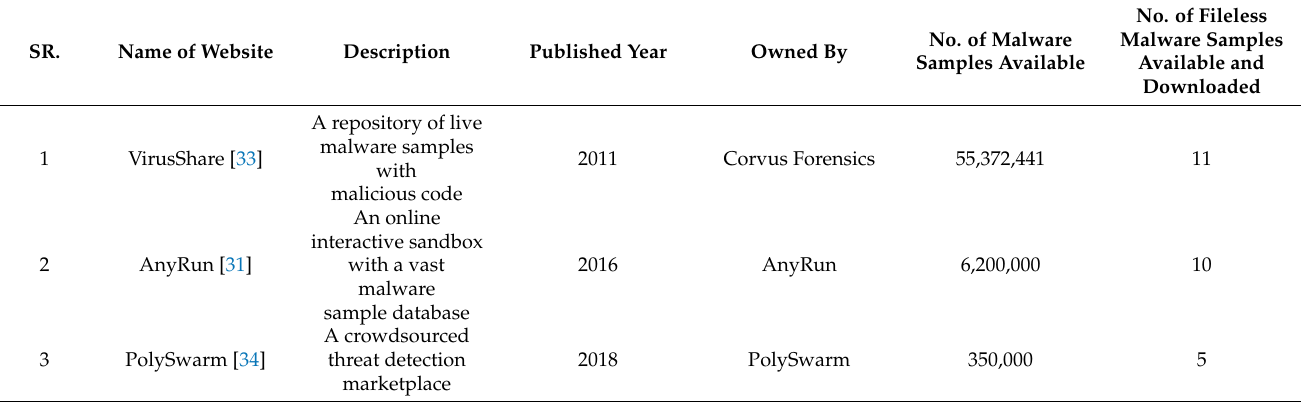
Table 5. Fileless malware samples